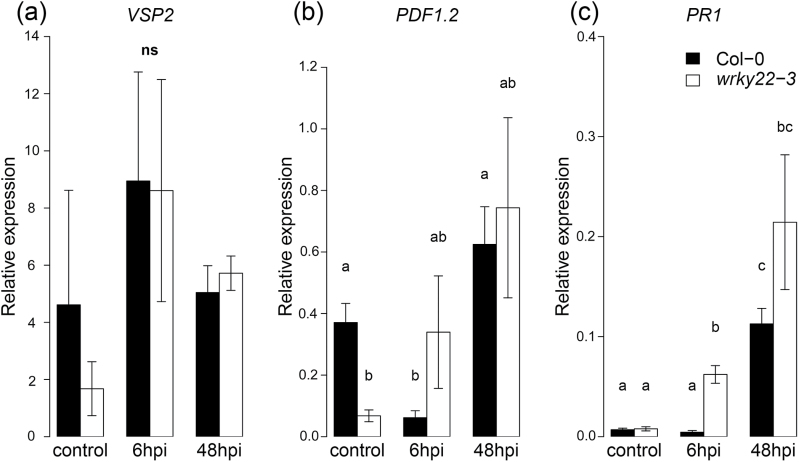
The effect of aphid infestation without clip cage on the expression of JA and SA reporter genes. RT-qPCR measurements of expression of the JA reporters VSP2 (A) and PDF1.2 (B), and the SA reporter PR1 (C) in wild-type and wrky22-3 plants (Student’s t-test and the Mann–Whitney U-test; different letters denote significant differences). Aphids were contained on the leaves without inflicting major mechanical stimulation (see Materials and methods).